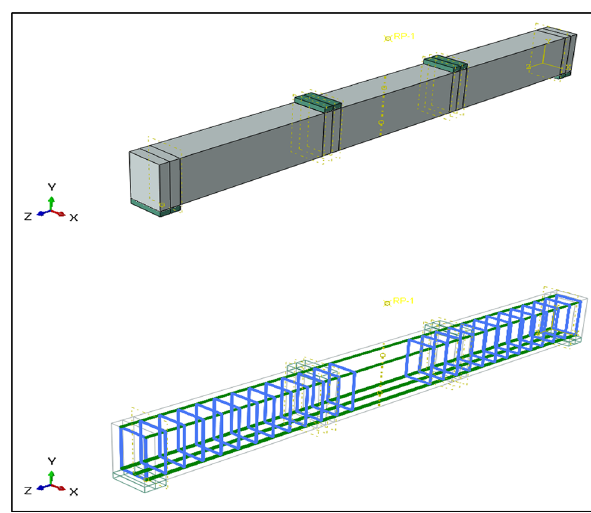
Figure 2: Assembly of beam.